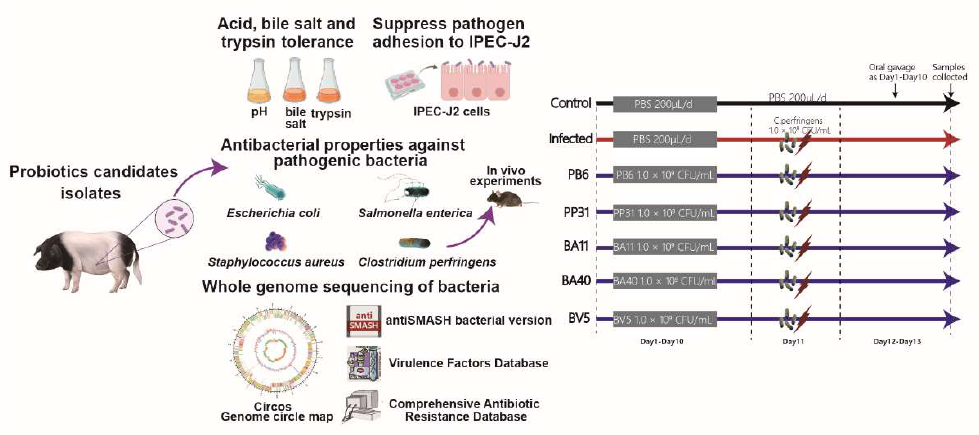
Figure 1. Experimental design.